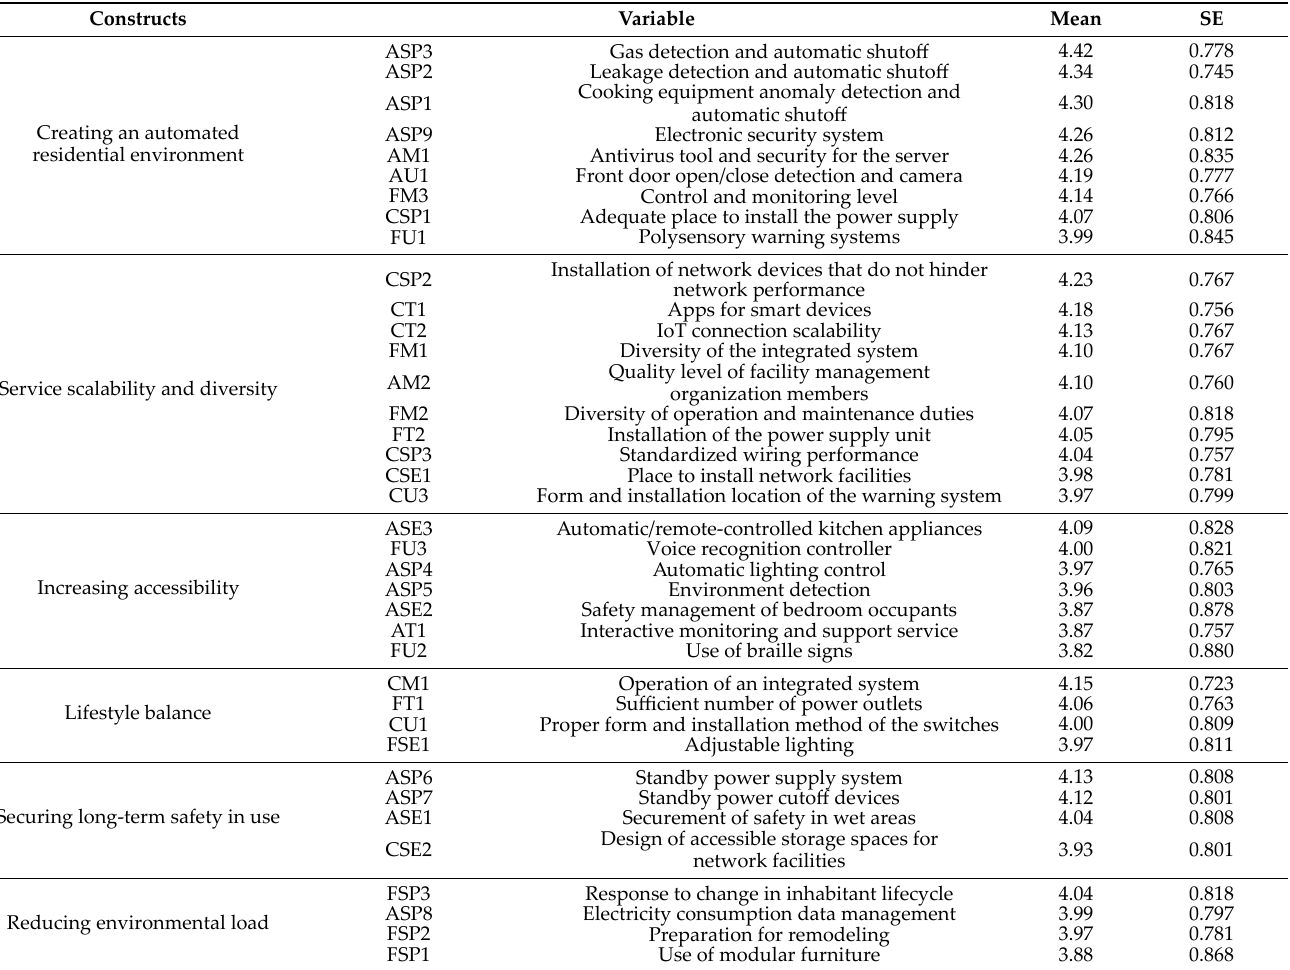
Table 6. Ranking of perceived importance by